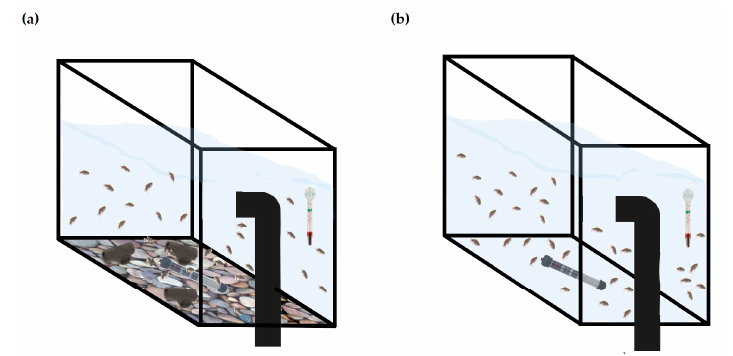
Figure 1. Schematic representation of enriched (with 3 PVC pipes and gravel image); ( a ) and barren ( b ) housing. All tanks had a heater and a thermometer inside the tank.